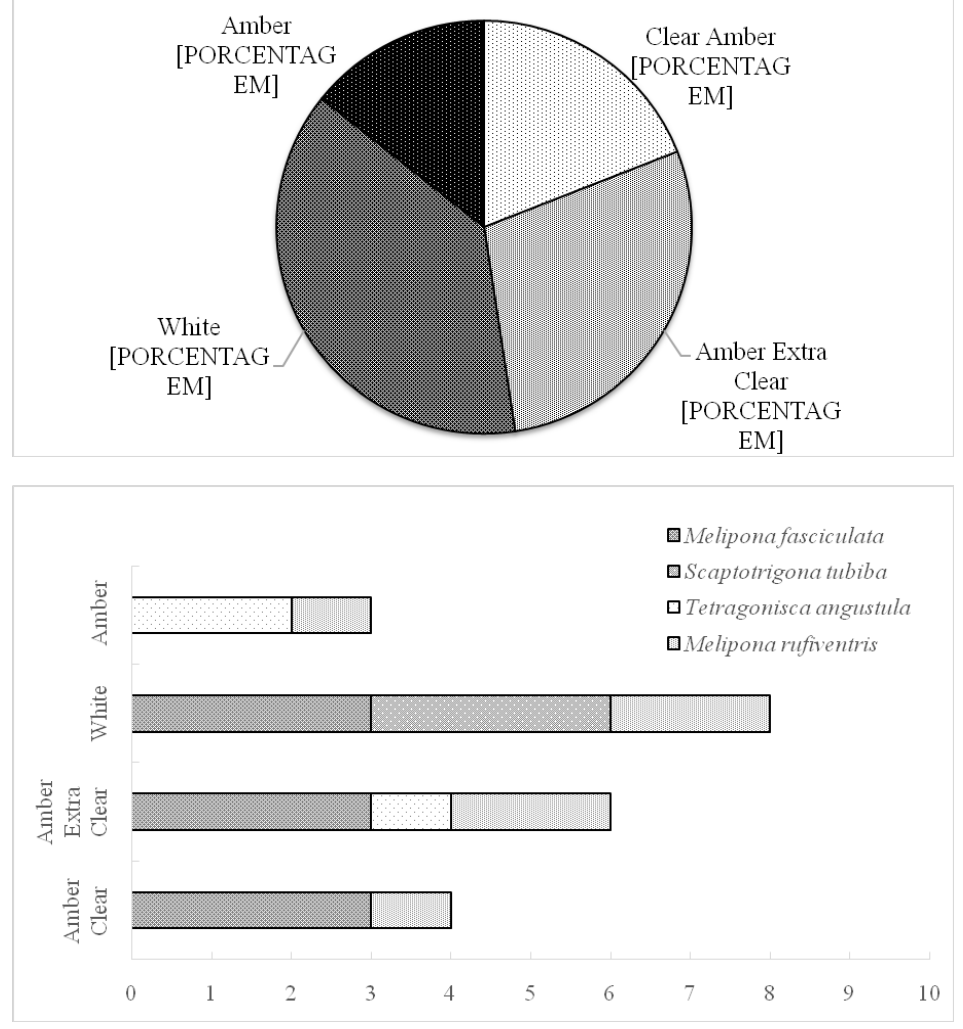
Fig 3 . Color parameter of honey produced by stingless bees in the municipalities of Palmas and Miracema in two harvest